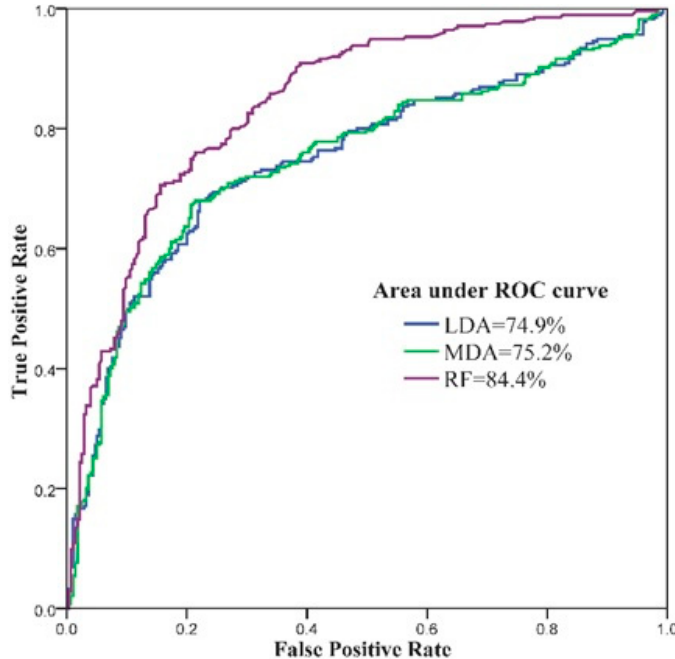
Figure 7. Receiver operating characteristics (ROC) curve calculated for the LDA, MDA and RF models.